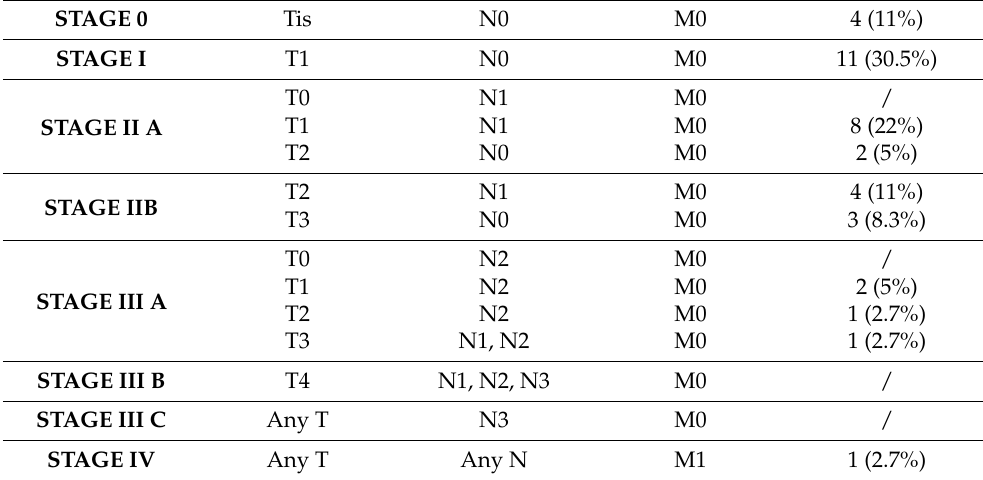
Table 3. TNM staging and classification of the case with BrC.